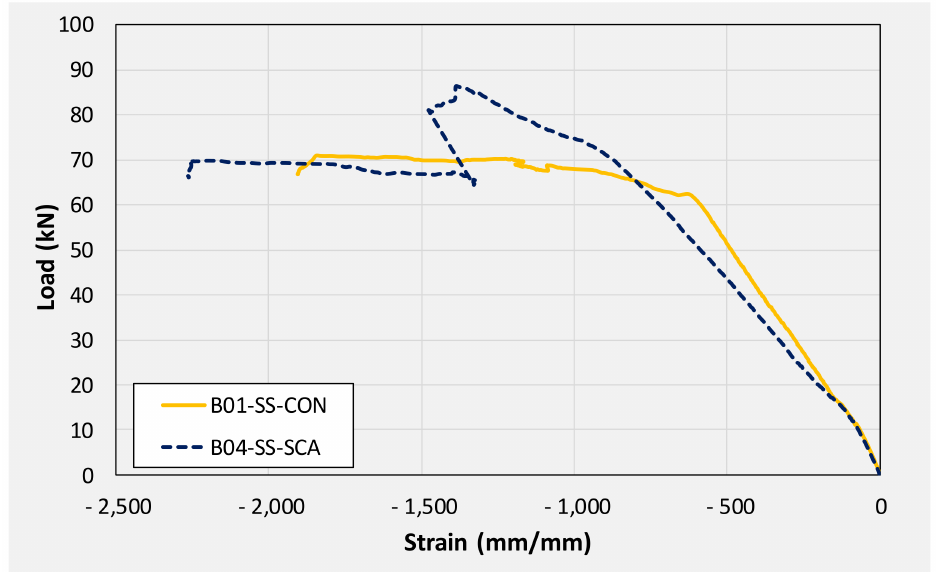
Figure 23. Monitored negative steel strain in solid section